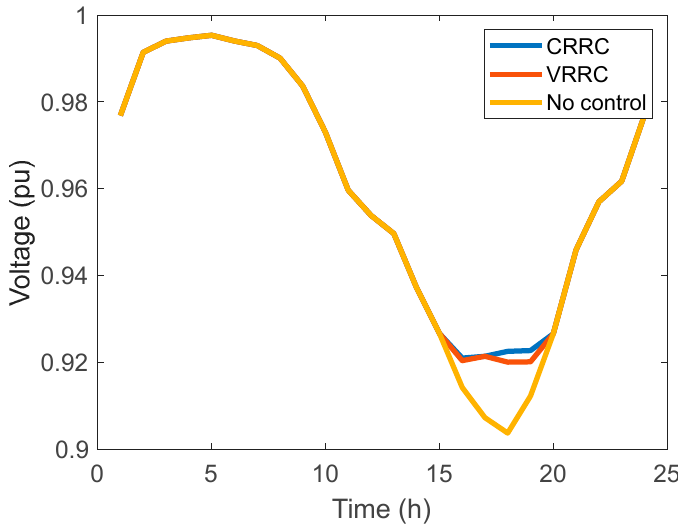
Figure 8. The lowest voltage profiles for each scenario.